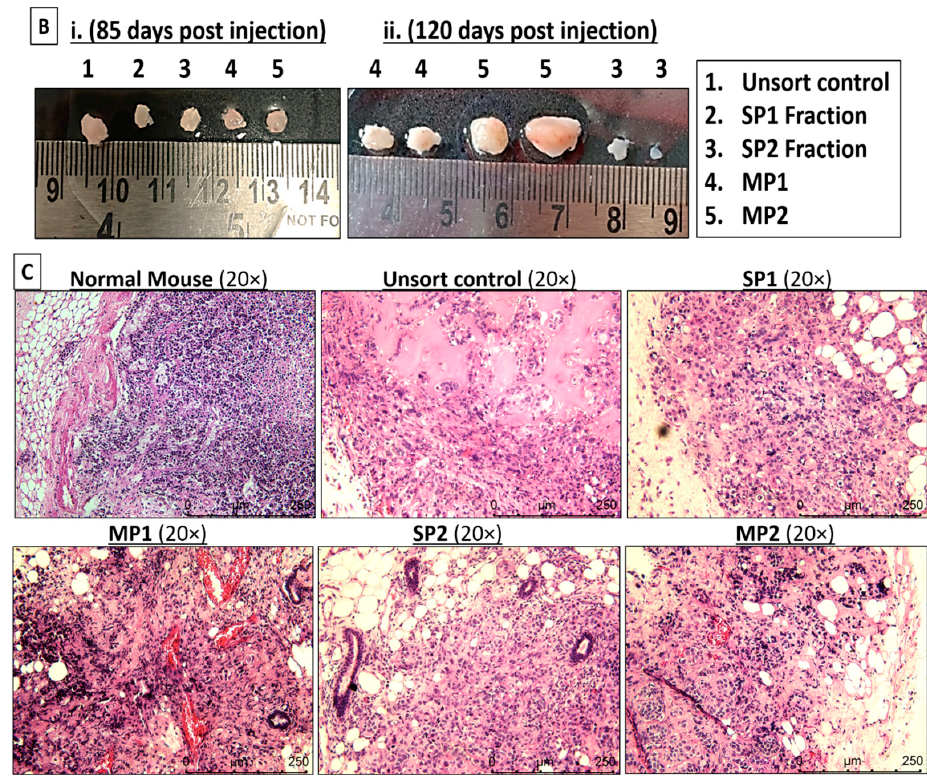
Figure 3. In vivo breast tumor repopulation assay in NSG mice. ( A ) The sorted fractions (SP1, SP2, MP1, and MP2) and a Hoechst-dye-stained unsorted control fraction (UC) of MCF7 cells were injected orthotopically (site of xenograft circled in yellow) in the fat pads of NSG mice (4 mice per fraction) to assess the differential tumorigenic potential of each fraction. ( B ) The xenografts were excised at the time points of (i) 85, 90, and (ii) 120 days after the initial date of injection. There was a visible difference in tumor volume generated by the fractions, indicating a differential rate of cell proliferation over the period of time. ( C ) Hematoxylin and eosin (H&E) staining revealed distinct pathological features such as the tissue morphology, aggressiveness, infiltration of blood vessels, and grade of tumors that varied between the xenograft tumors from UC, SP1, SP2, MP1, and MP2 fractions (scale bar measures 250 µm, representing a magnification of 20×). An image of normal mouse mammary gland tissue was included for comparison between human and mouse breast tissues.